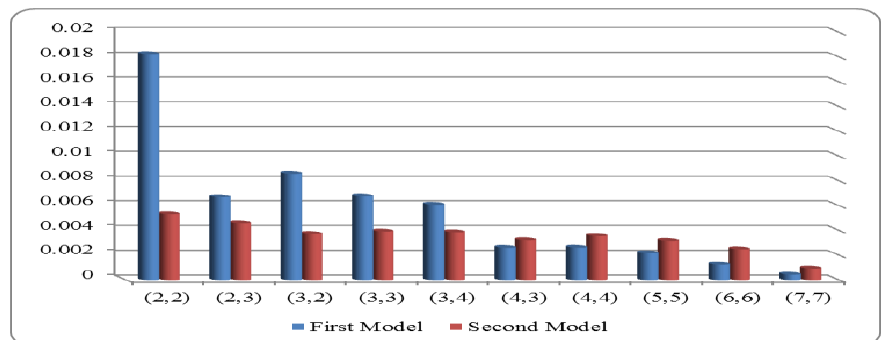
Figure 3. MSEs of ˆ R 1 and ˆ R 2 for both models at R = 0.71.